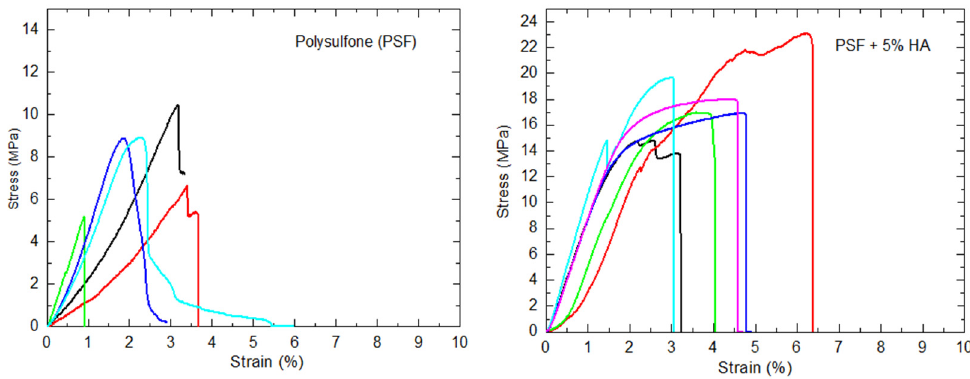
Figure 10. Stress (MPa) vs. strain (%) plots for the samples under study PSF; PSF + 1% HA; PSF + 2%HA; PSF + 5% HA; and PSF +10% HA. 2%HA; PSF + 5% HA; and PSF +10%